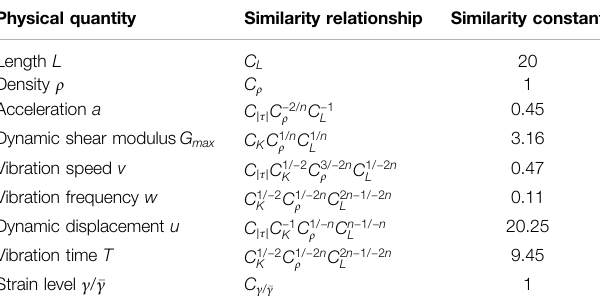
TABLE 4 | Similarity relationship of physical quantities of the test model.